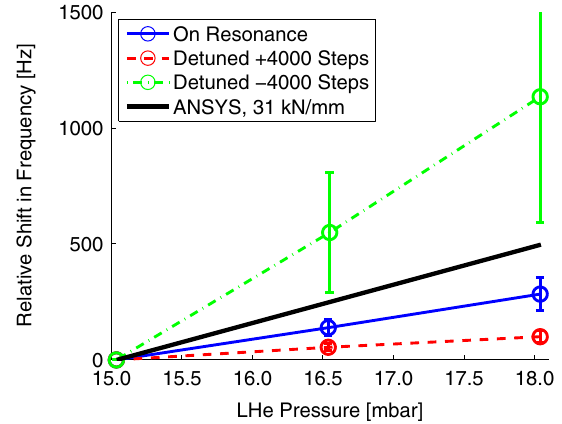
FIG. 6. df=dp of the 7-cell cavity for several wall thicknesses from 2 to 4 mm and tuner stiffnesses from 50 to 200 kN = mm , as a function of the radial position of the stiffening ring, given as a fraction of the iris-equator distance [i.e. ð r ð r (cid:2) r Þ ]. equator iris